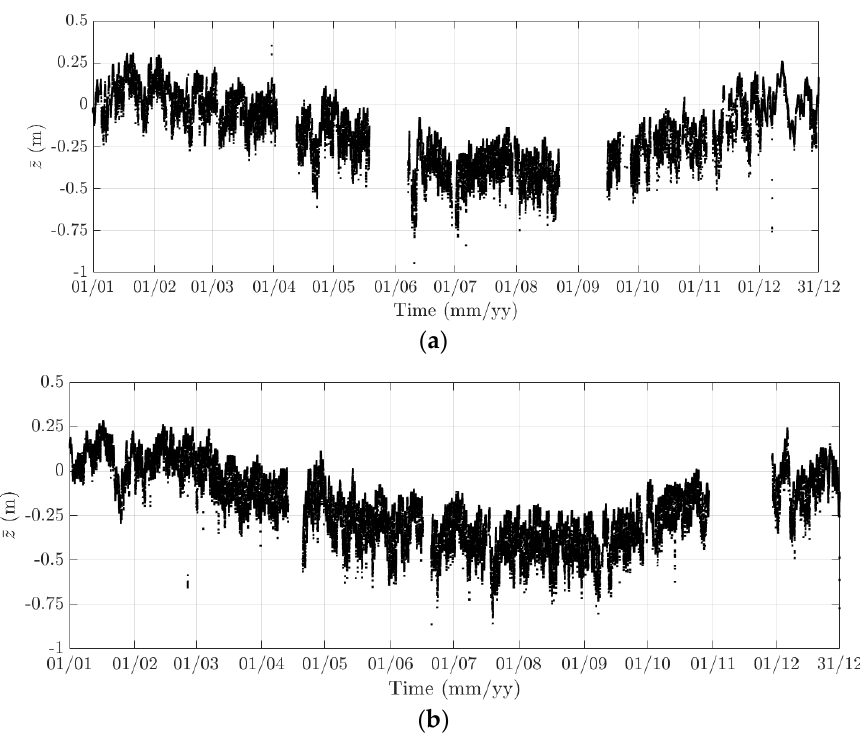
Figure 14. Variation of the 10 ‐ min mean of the heaving response at the mid span of the FRB in ( a ) 2015 and ( b ) 2016.